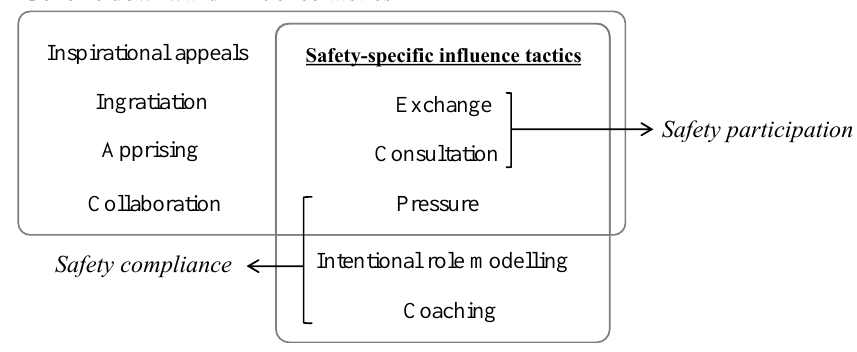
Figure 3. Identified influence tactics for safety behaviours in the maritime context.